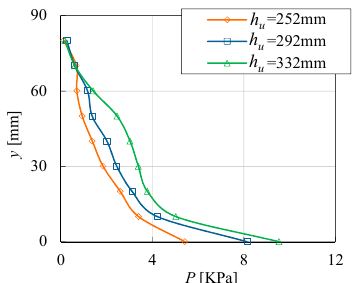
Figure 8. Vertical distribution of wave pressure on the structure under different water column